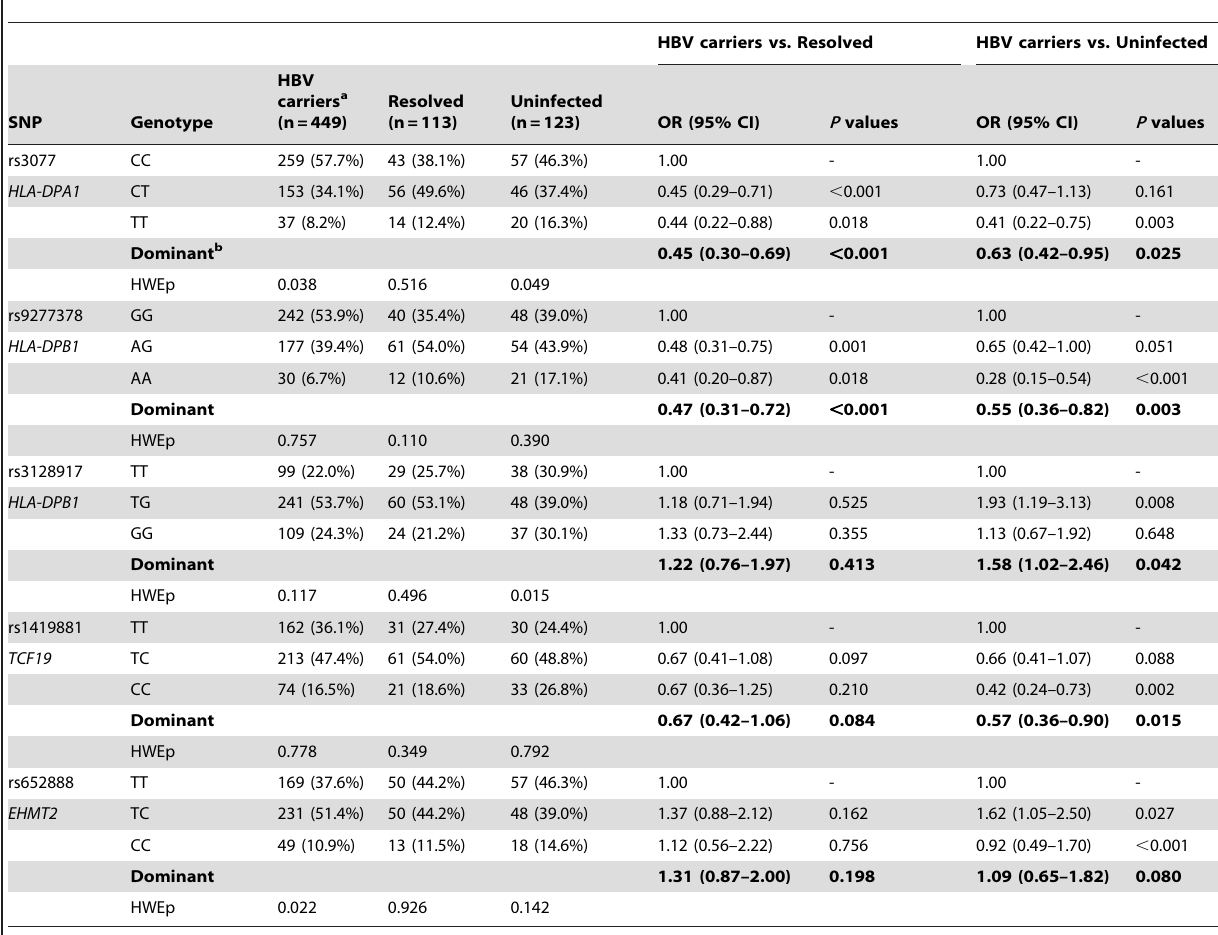
Table 3. Genotype frequencies in HBV carriers, resolved HBV and uninfected subjects in Thailand.